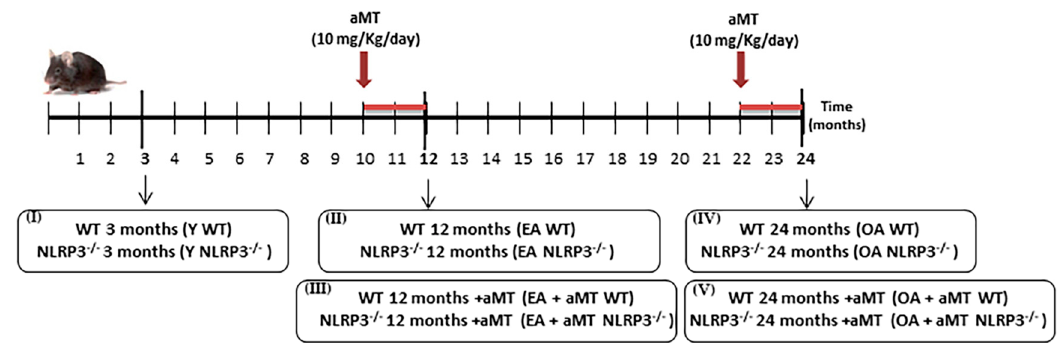
Figure 1. Study design summary: experimental groups and melatonin treatment.